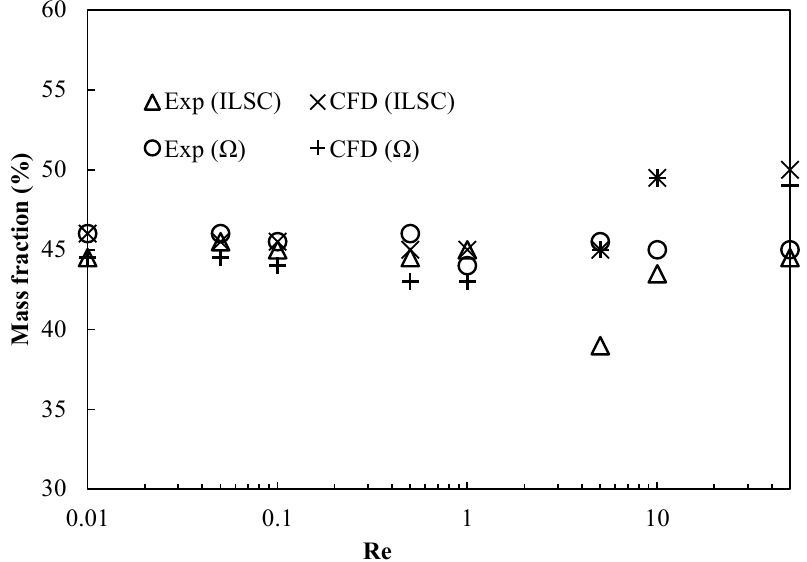
Figure 13. Comparison of mass fraction percentage of experimental and numerical results at channel